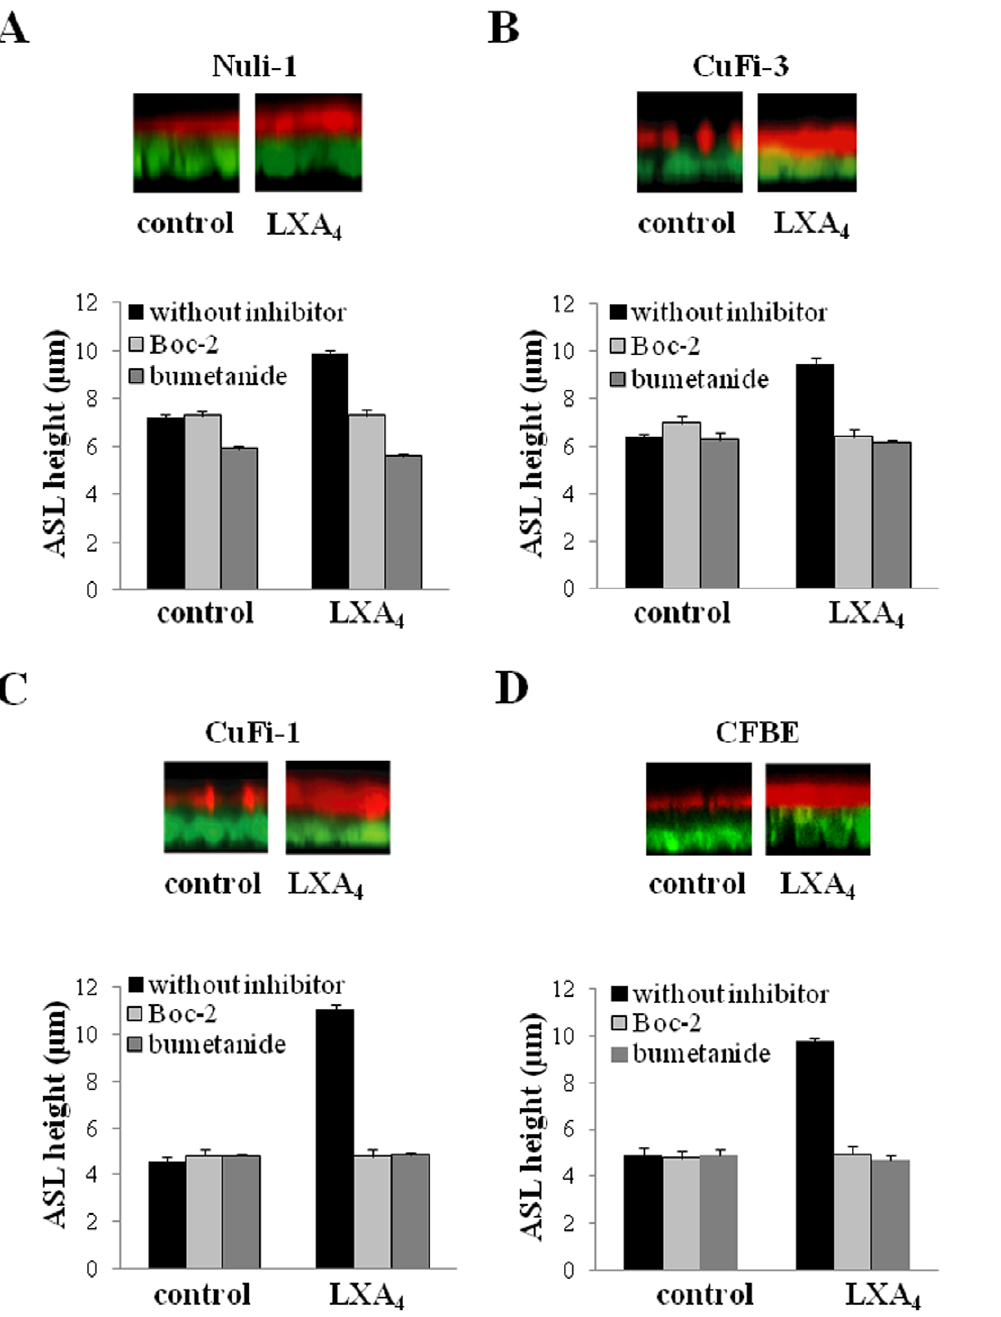
Figure 6. LXA 4 (100 nM) effects on airway surface liquid height in NuLi-1 (A), CuFi-3 (B) and CuFi-1 epithelial cell line (C) and CFBE primary cultures (D). Epithelial cells were stained with calcein green, and the ASL labelled with dextran-conjugated Texas red TM fluorochrome. For each cell preparation, typical z-plane confocal sections showing ASL responses to LXA 4 (top) and mean ASL height changes (bottom) in control conditions or following LXA 4 (100 m M) exposure in NuLi-1,CuFi-3, CuFi-1 and CFBE epithelia treated or not with Boc-2 (10 m M) and with bumetanide (10 m M).